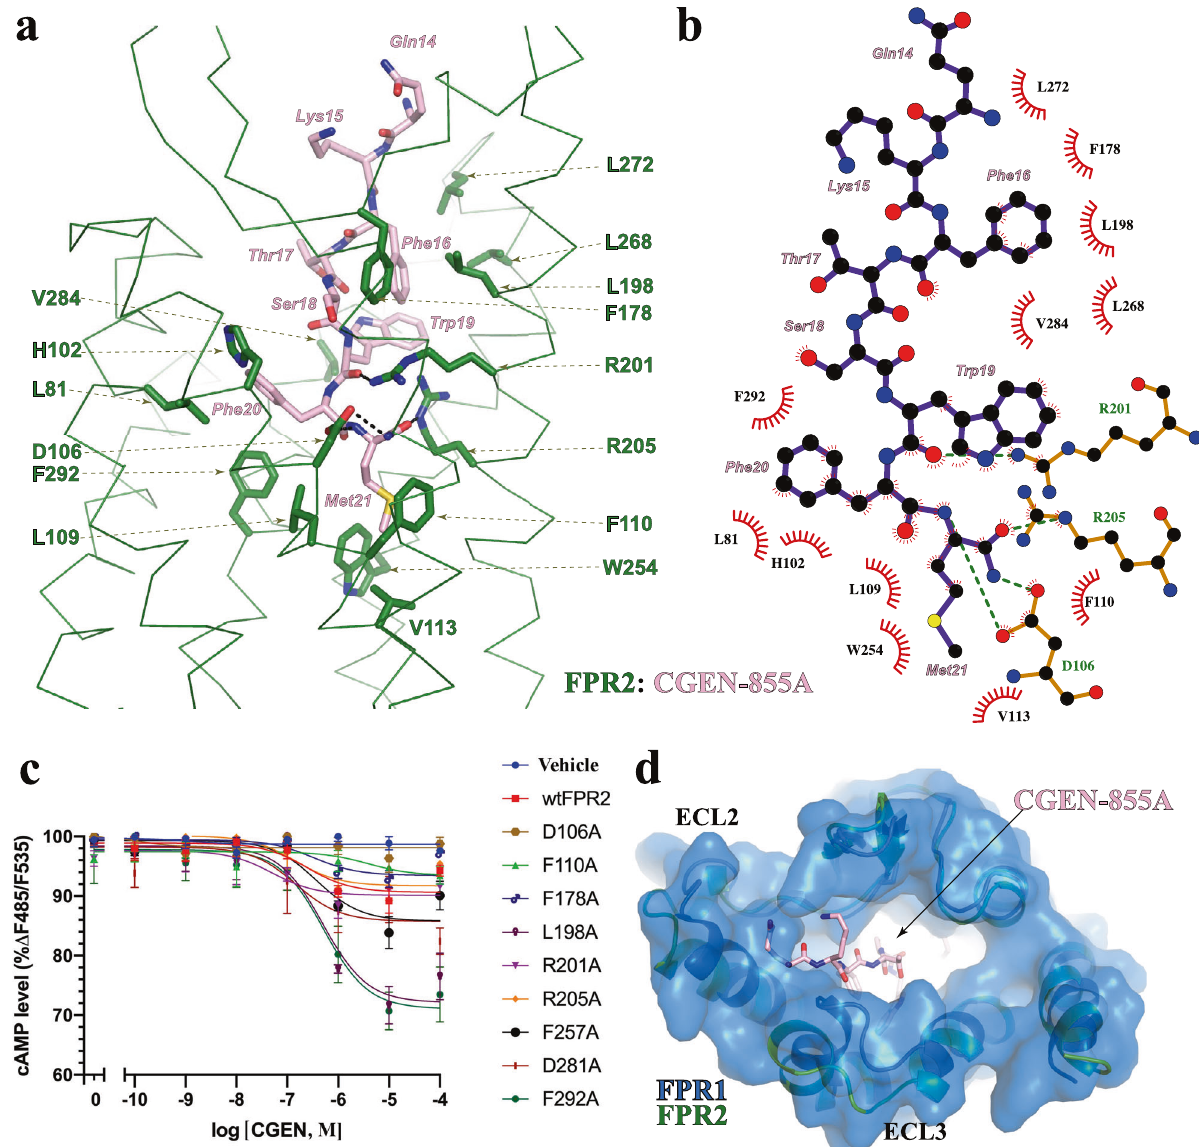
Fig. 5 Binding of CGEN-855A to FPR2. a Details of CGEN-855A-binding pocket. b Ligplot schematic representation of CGEEN-855A interactions with FPR2. The carbon, nitrogen, oxygen, and sulfur atoms are colored in black, blue, red, and yellow, respectively. The ligand is shown as purple sticks. Residues in FPR2 that form polar interactions with CGEEN-855A are shown with green labels. Polar interactions are shown as green dashed lines. c Dose-dependent action of CGEN-855A on wide type FPR2 (wtFPR2) and mutants measured by cAMP accumulation assay. Each data point represents mean ± S.D. Three independent assays were performed. d Structural alignment of the CGEN-855A-bound FPR2 to FPR1 showing clash of CGEN-855A with the extracellular region of FPR1. Source data are provided as a Source Data fi